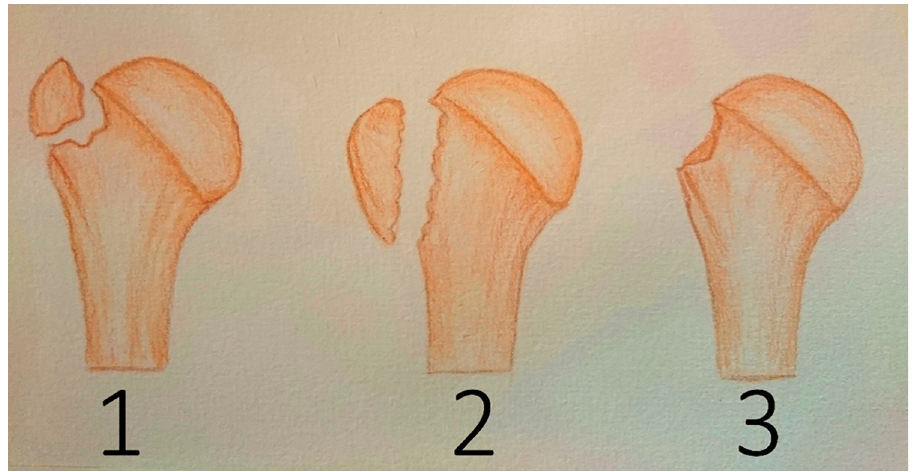
Fig 1. Morphological Mutch classification system. Illustration shows the three types of the morphological Mutch classification (type 1: avulsion, type 2: split, type 3: depression).